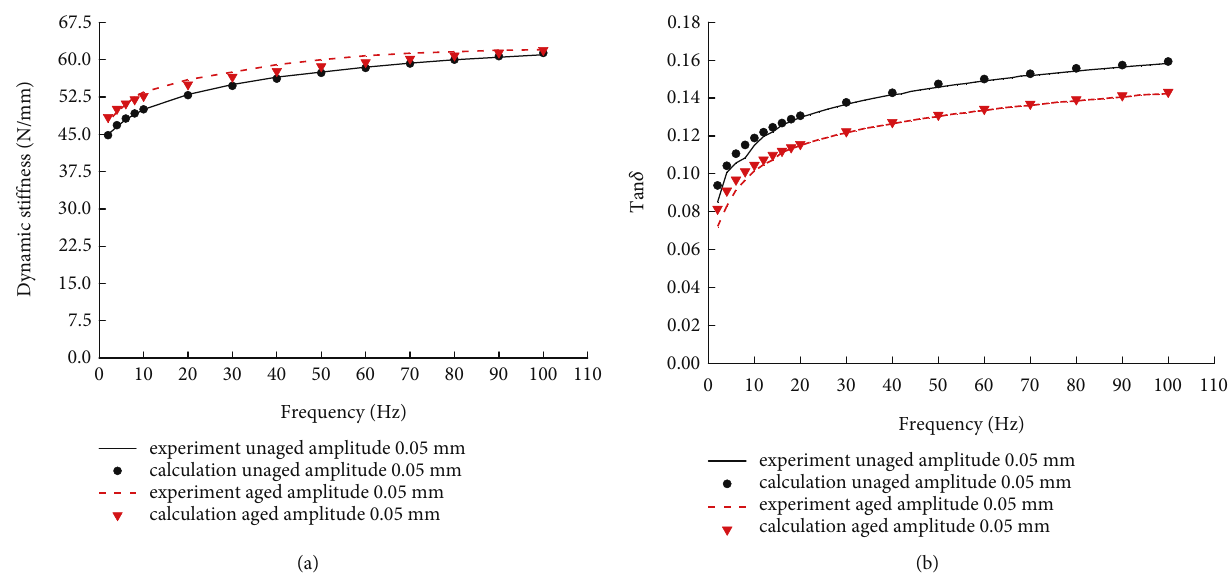
Figure 14: Dynamic sti ff ness and loss factor under the amplitude of 0.05mm. (a) Dynamic sti ff ness with or without thermal oxygen aging, and (b) loss factor with or without thermal oxygen